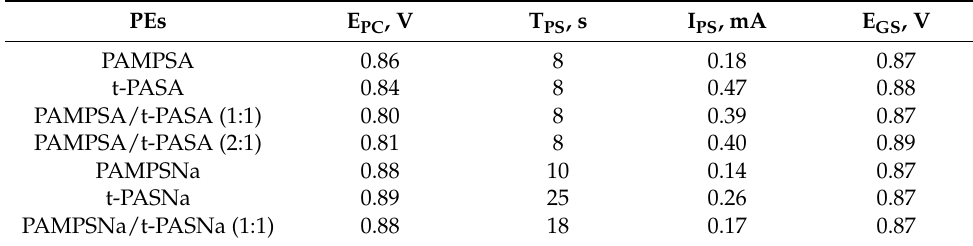
Table 1. Electrochemical parameters of different regimes of PEDOT electrosynthesis in the presence of various PEs and their mixtures.